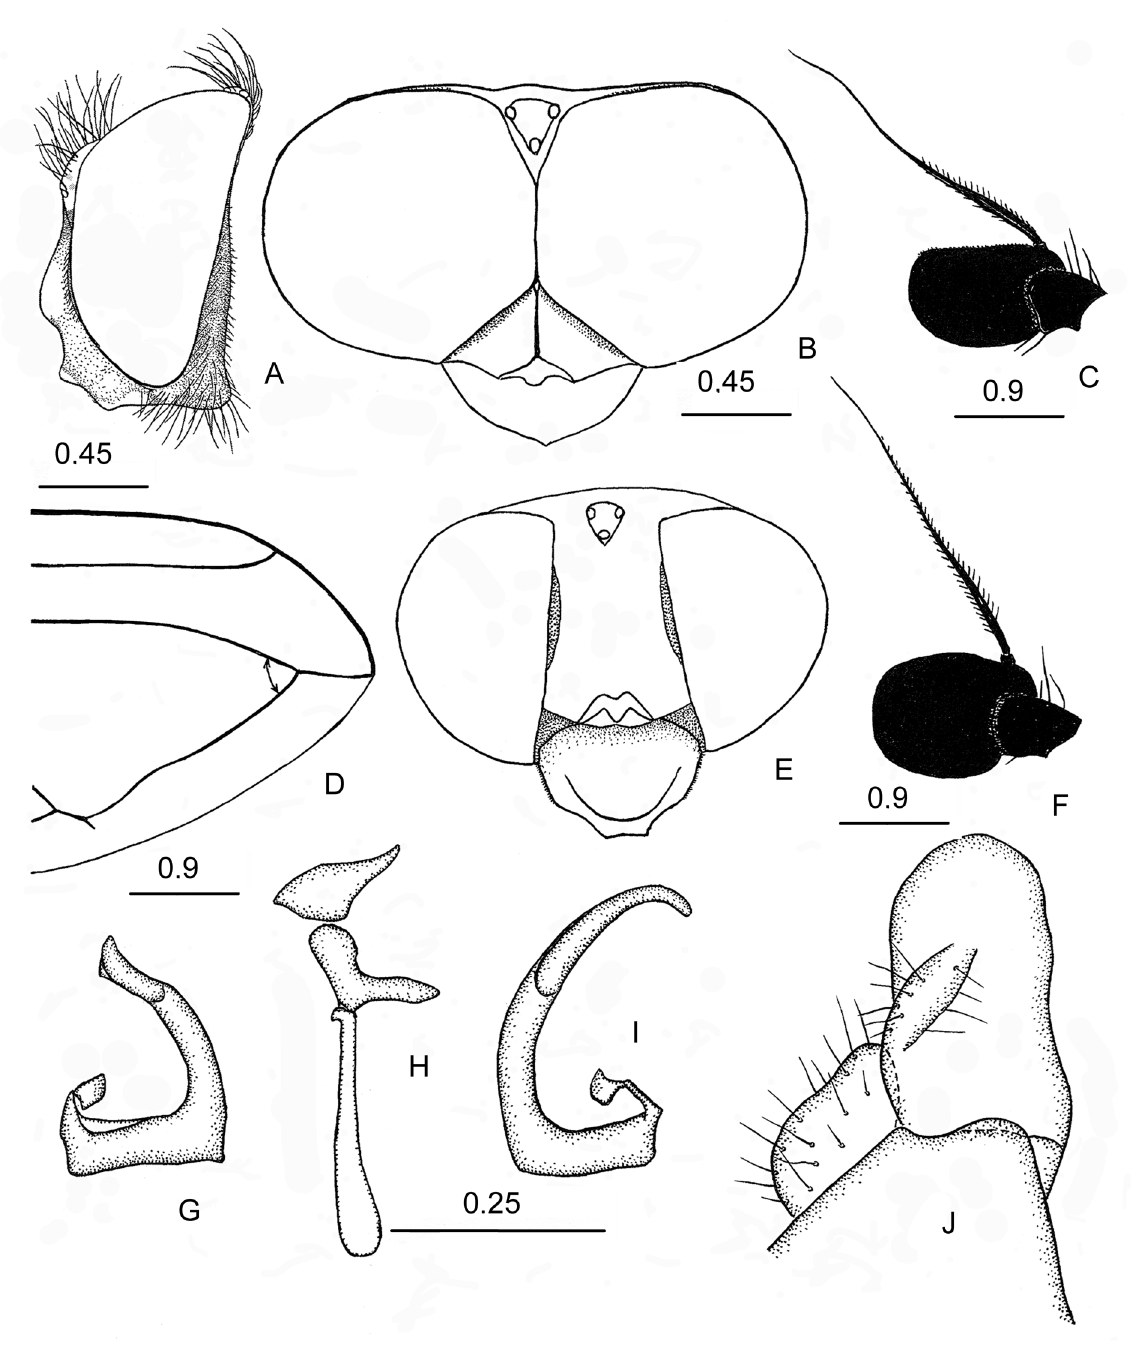
Fig. 54. Cheilosia ( Eucartosyrphus ) procera sp. nov.; A–D, G–J = paratype, ♂ (IBSJW/NME), E–F = paratype, ♀ (IBSJW/NME). A . Head, lateral view. B, E . Head, dorsal view. C, F . Antenna, lateral view of pedicel and basoflagellomere. D . Tip of wing. G, I . Superior lobes of hypandrium, lateral view. H . Aedeagus and aedeagal apodeme, lateral view. J . Surstylus and gonocercus, lateral view. Scale bars indicated in